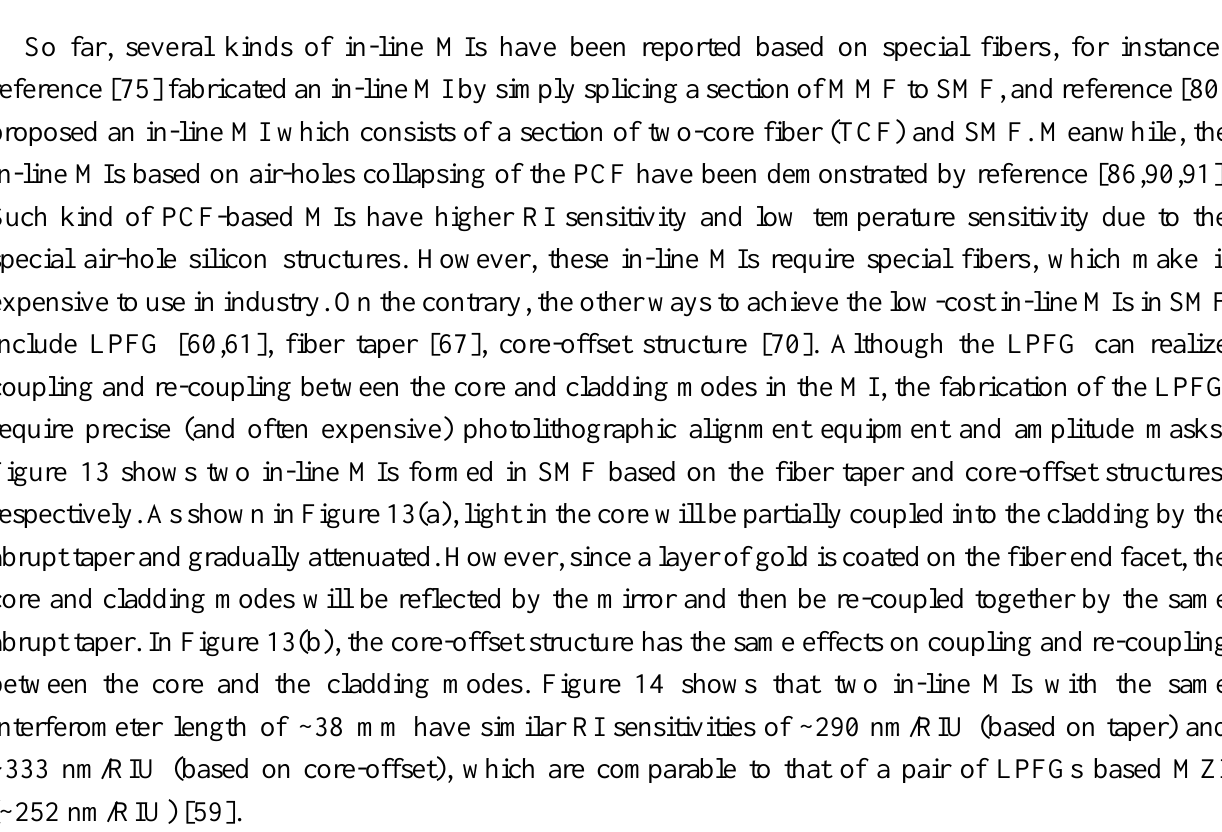
Figure 13. Schematic of two in-line MIs based on: ( a ) the fiber taper; ( b ) the core-offset structure, respectively.